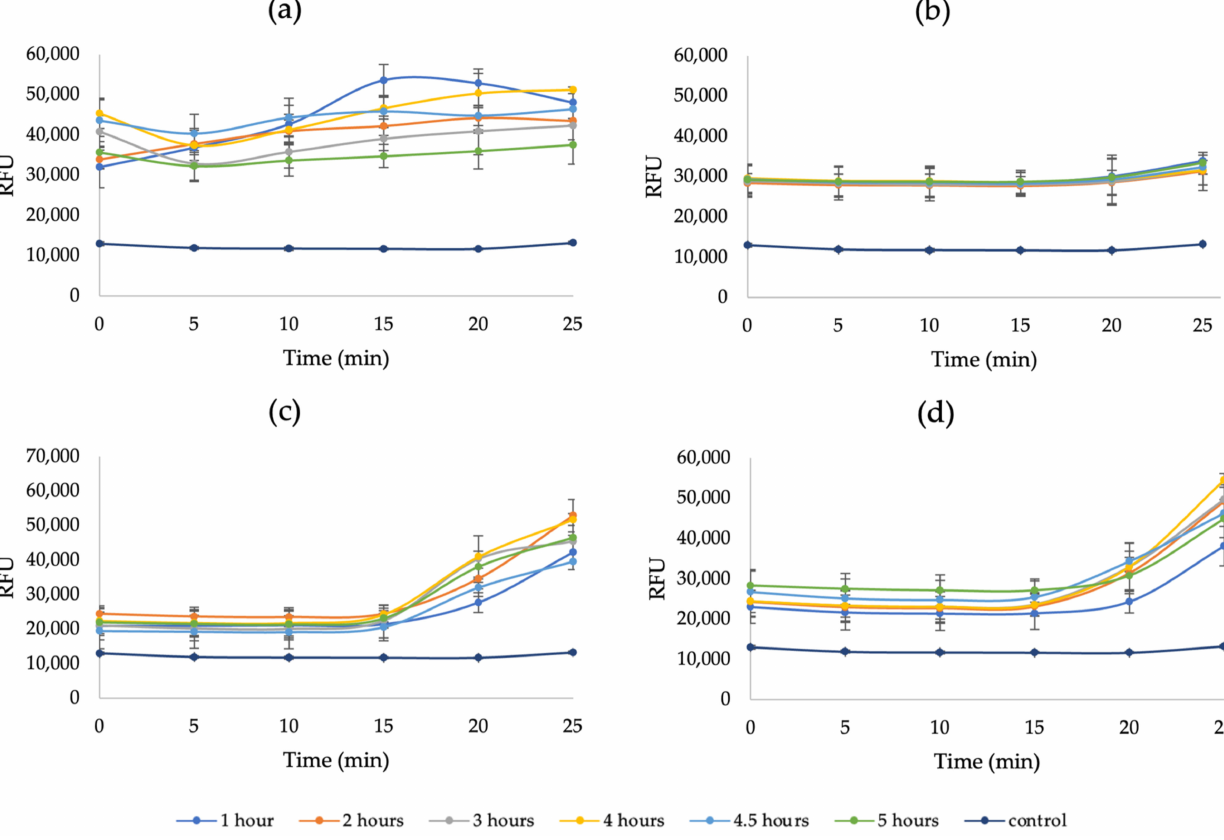
Figure A6. The RFU of a 3-h pretreated RPS hydrolysis: ( a ) before centrifugation, ( b ) after 1 centrifu- gation, ( c ) after 2 and ( d ) 3 centrifugations (6000 rpm, 15 min); 0.4% KOH (pH = 13), 0.1%